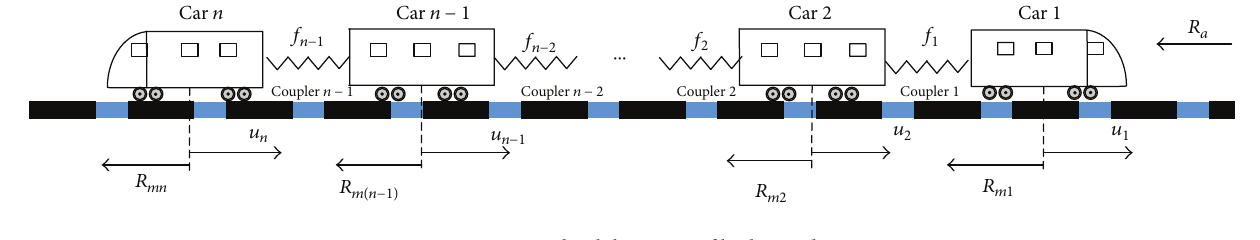
Figure 1: Longitudinal dynamics of high speed